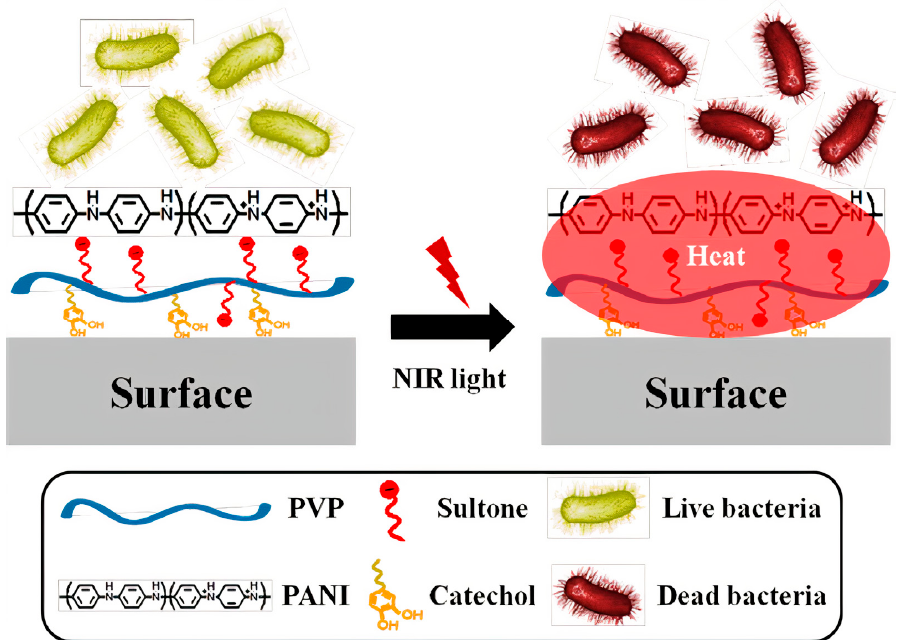
Figure 12. Scheme for the preparation and application of poly (vinyl pyrrolidone) sulfobetaine:poly aniline (PVPS:PANI) coating and near − infrared radiation (NIR) for the photothermolysis of bacteria. Reprinted with permission from [177]. Copyright 2015 American Chemical Society.